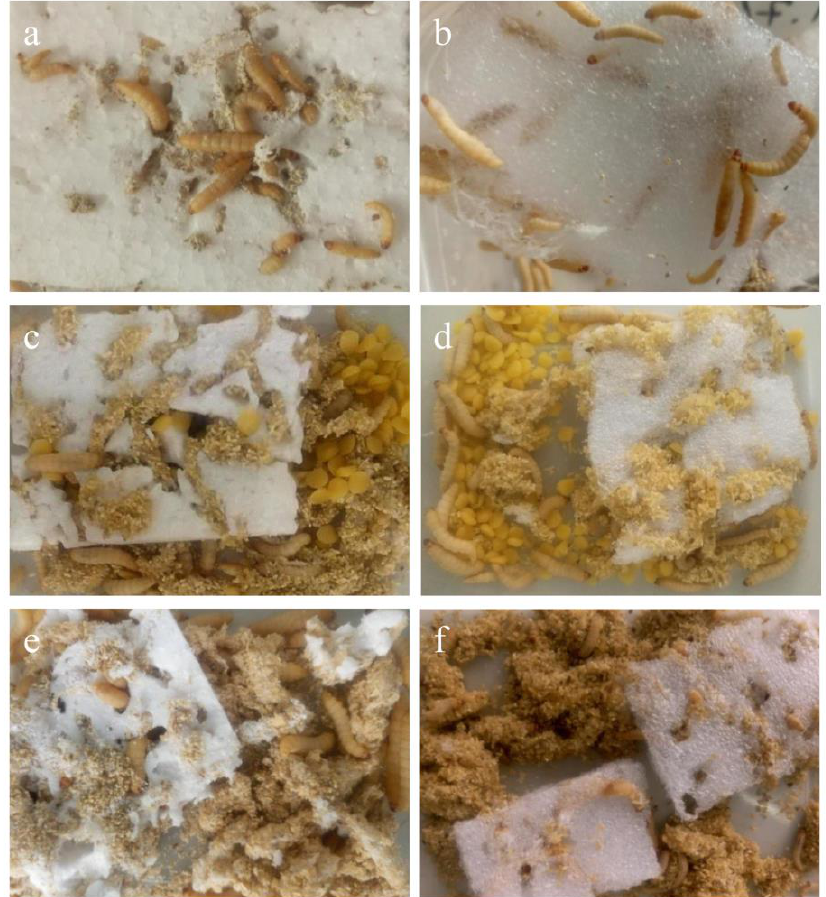
Figure 6. Plastic and supplementary nutrients were ingested by the greater wax moth larvae fed a PS diet ( a ), a PE diet ( b ), a PS + beeswax diet ( c ), a PE + beeswax diet ( d ), a PS + bran diet ( e ), and a PE + beeswax diet ( f ), reprinted with permission from [39].